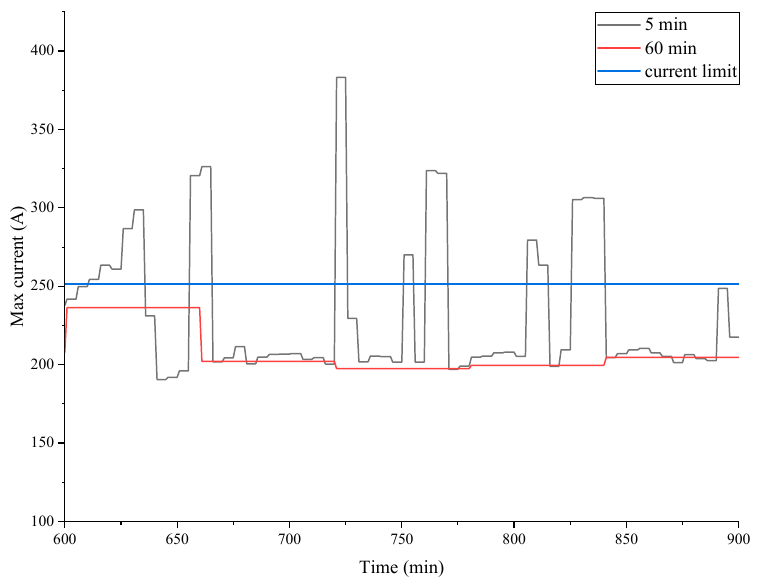
Figure 2. Comparison of current magnitudes between 5 and 60 min average power output.